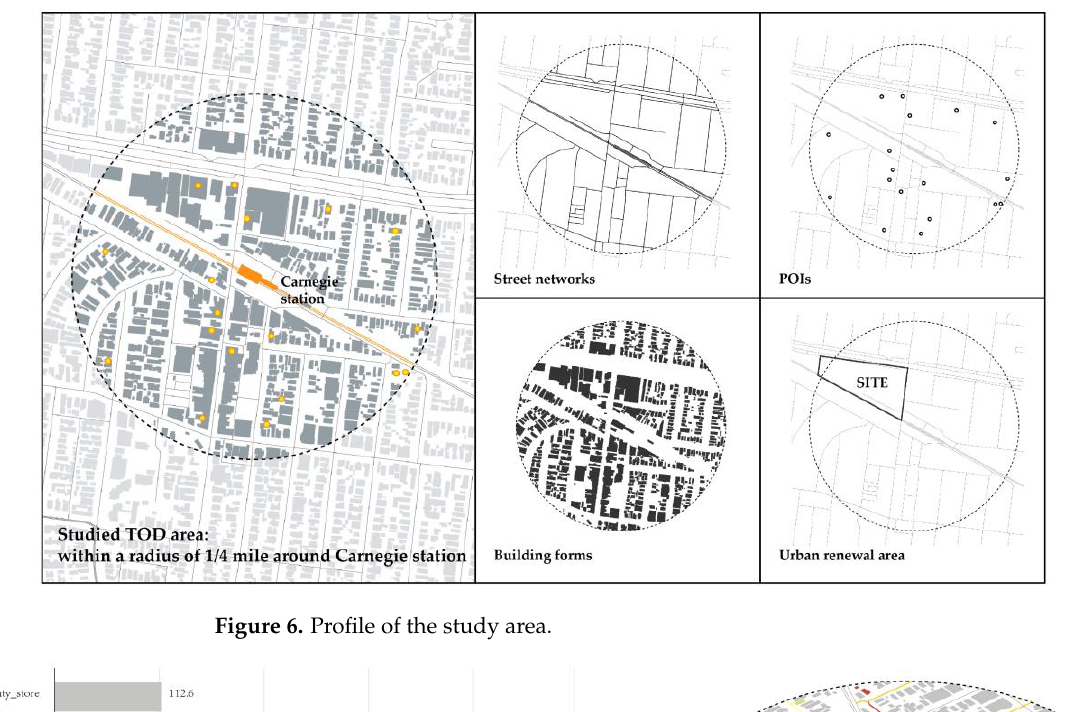
Figure 6. Profile of the study area.